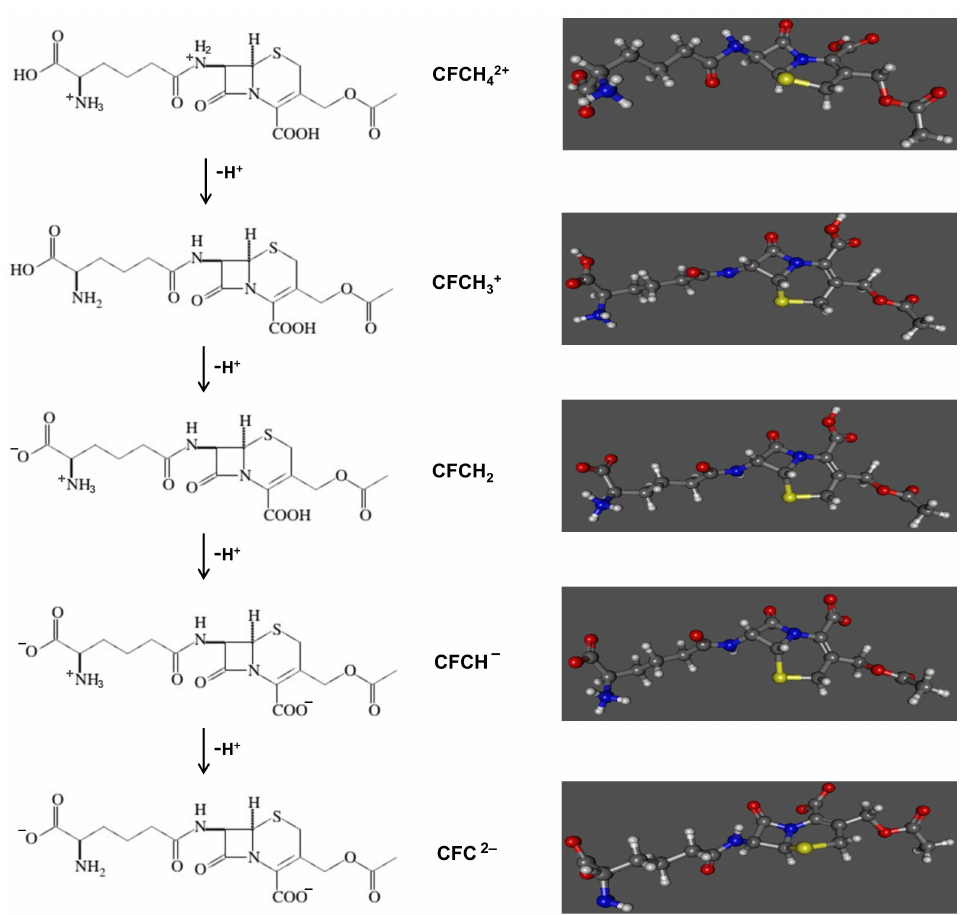
Figure 3. Representation of the different chemical structures of cephalosporin C in aqueous